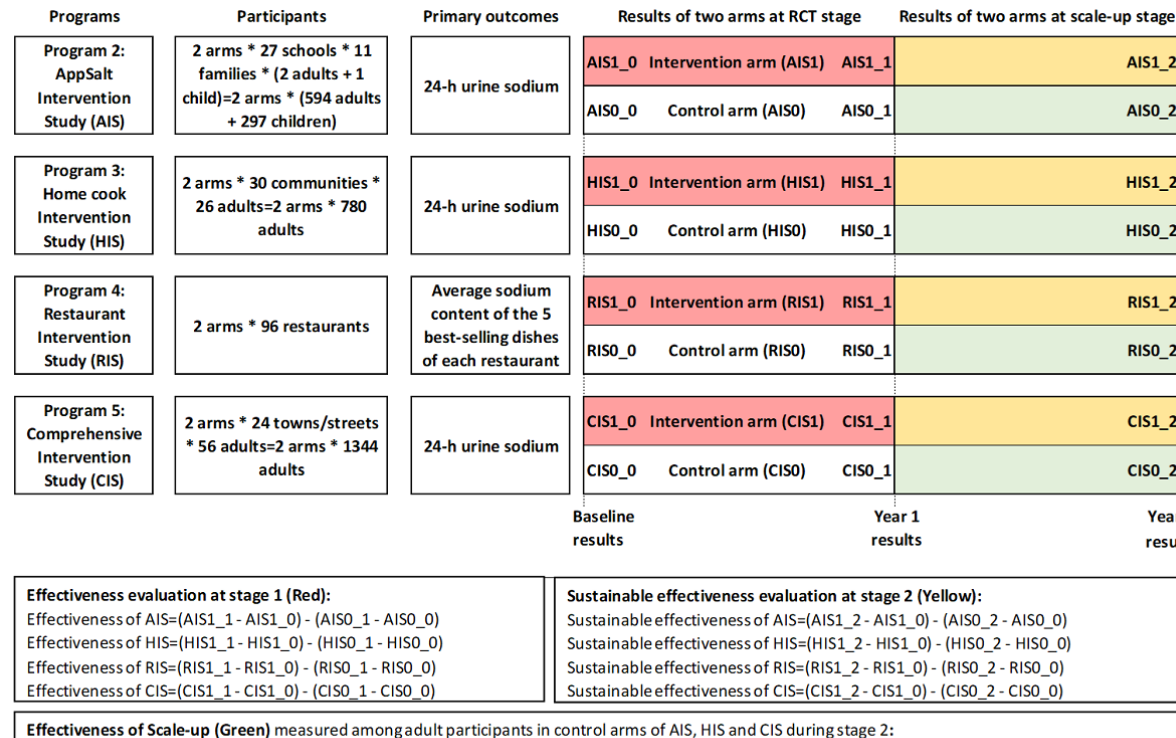
Figure 3. Design for the evaluation of the four cluster randomized controlled trials in Action on Salt China (ASC) Programs